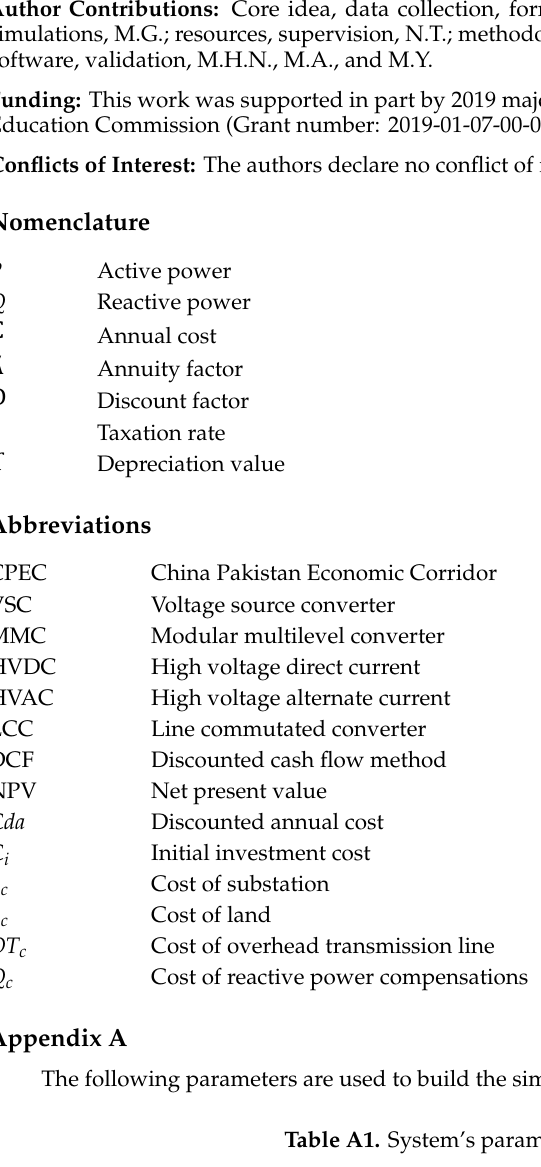
Table 3. HVAC and HVDC systems investment cost comparison [8,9,38].